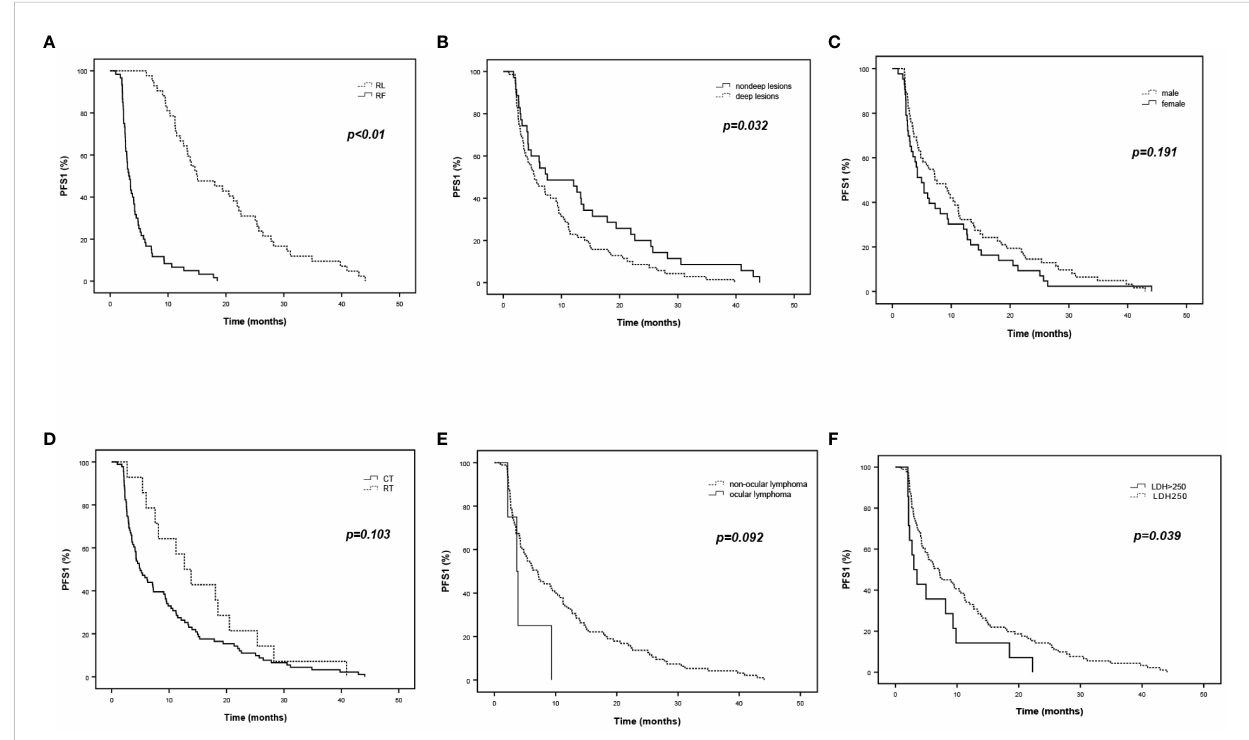
FIGURE 2 Survival curves of PFS1 in R/R PCNSL. (A) . PFS1 (the time from diagnosis to the fi rst time of recurrence or refractory progression) of the RL and RF group. B-F. Prognostic factors for initial recurrence or progression according to PFS1. (B) Position of lesions. (C) Gender. (D) Induction therapy. (E) Ocular lymphoma. (F) Level of serum